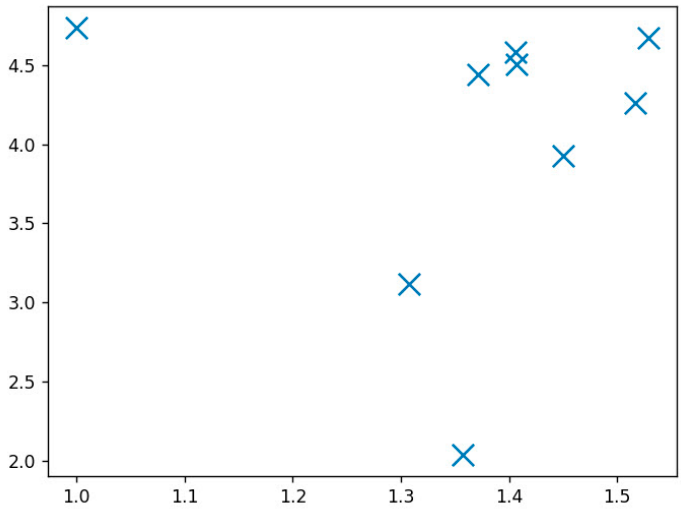
Figure 5. K-means Figure 5. K-means algorithm. Figure 5. K-means algorithm.